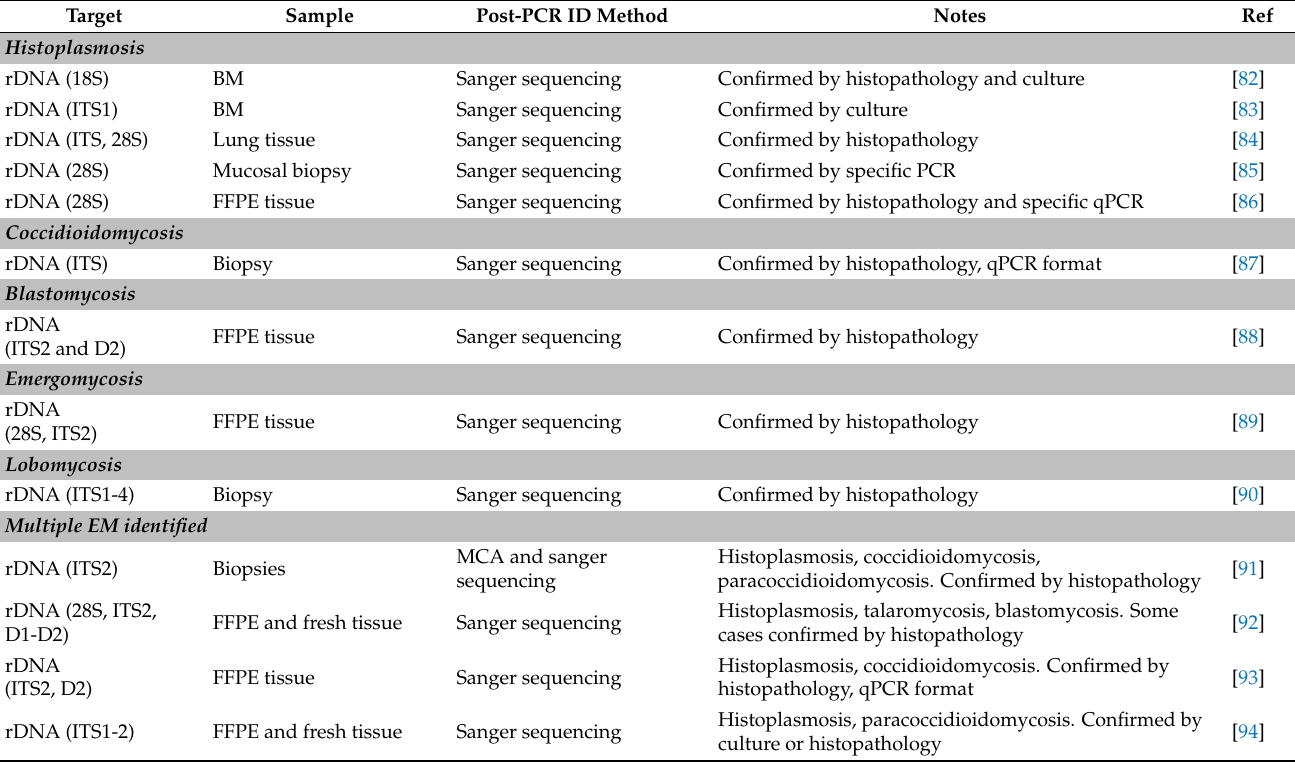
Table 2. Details of the studies where broad-range PCR was used to diagnose endemic